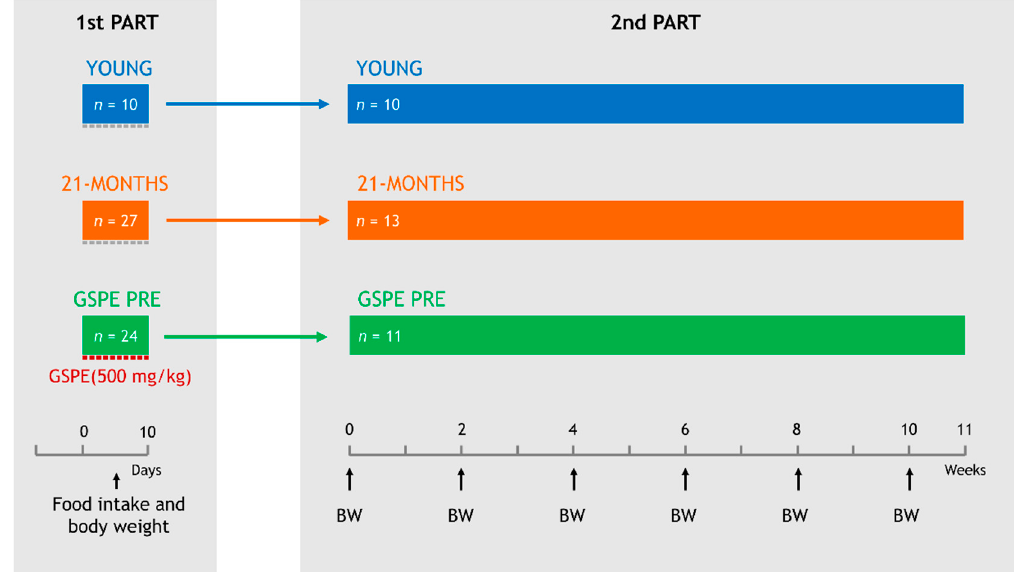
Figure 1. Schematic diagram of the experimental design. The experiment was divided into two parts. In the first part, the group named GSPE PRE animals were gavaged daily with a dose of 500 mg/kg of grape seed-derived procyanidins (GSPE) for 10 days while YOUNG and 21-MONTHS animals were gavaged with a vehicle. Food intake was recorded daily and body weight (BW) was measured after the 10 days of treatment. In the second part, all rats were maintained equally for 75 days and body weight was recorded every two weeks.